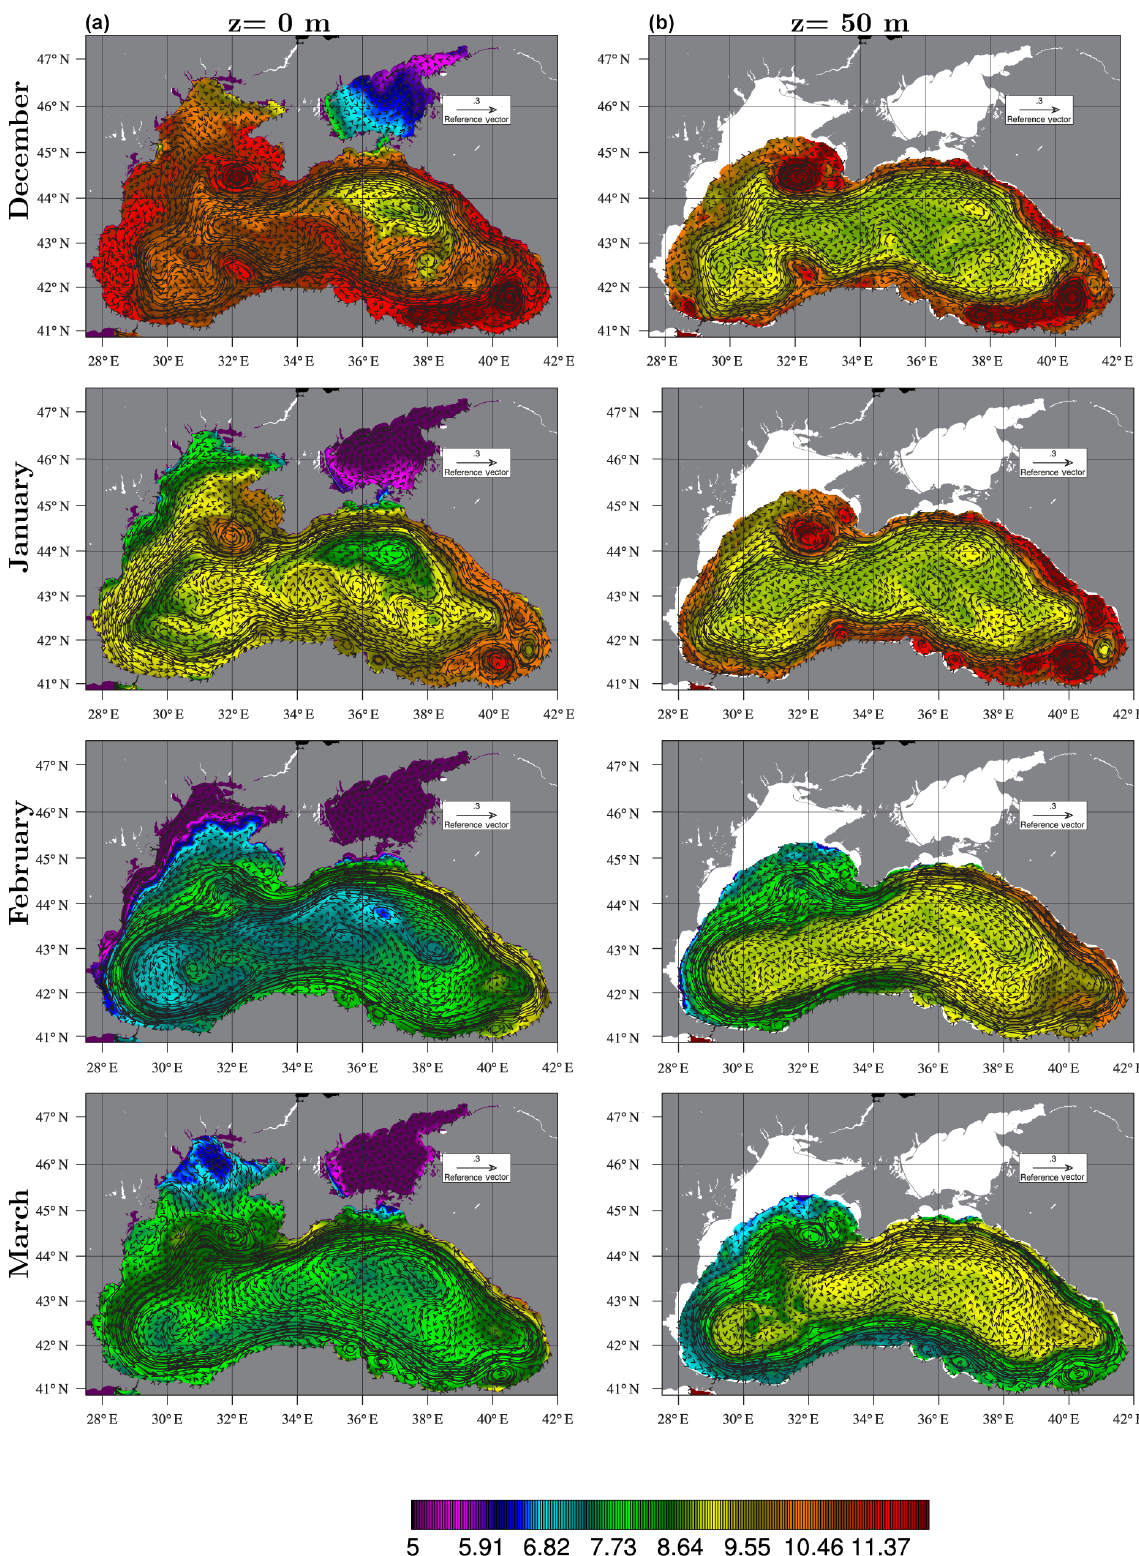
Figure 12. Monthly average currents and temperature at the surface (a) and at a depth of 50m (b) developed from December 2011 to March 2012 (ordered down the